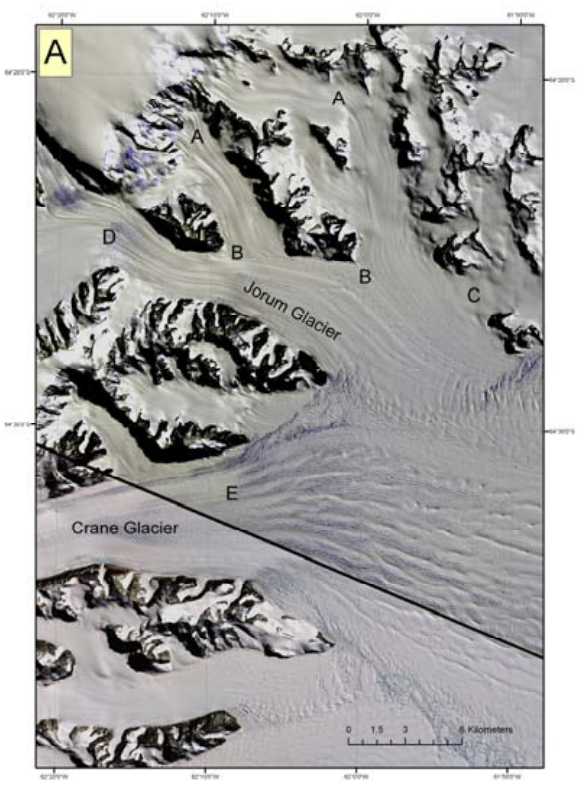
Fig. 4b. Interpretation of key surface structures. Point A indicates Figure 4B. Interpretation of key areas where longitudinal surface structures are developed immedi- Figure 4B. Interpretation of key ately below cirque headwalls. Point B indicates the development of surface structures. Point A surface structures. Point A longitudinal surface structures where two large outlet glaciers con- indicates areas where longitudinal verge. Point C indicates development of longitudinal surface struc- indicates areas where longitudinal tures at glacier margins. Point D indicates persistence of longitu- surface structures are developed surface structures are developed dinal surface structures through a crevassed zone. Point E shows immediately below cirque rapid truncation of longitudinal surface structures where crevasses immediately below cirque are initiated at the grounding line of the ice shelf. headwalls. Point B indicates the headwalls. Point B indicates the development of longitudinal surface development of longitudinal surface structures where two large outlet Crane and Jorum Glaciers (Fig. 4): these two glaciers structures where two large outlet glaciers converge. Point C glaciers converge. Point C indicates development of indicates development of longitudinal surface structures at longitudinal surface structures at glacier margins. Point D indicates glacier margins. Point D indicates persistence of longitudinal surface persistence of longitudinal surface structures through a crevassed structures through a crevassed zone. Point E shows rapid zone. Point E shows rapid truncation of longitudinal surface truncation of longitudinal surface structures where crevasses are structures where crevasses are initiated at the grounding line of the initiated at the grounding line of the ice shelf. ice shelf.